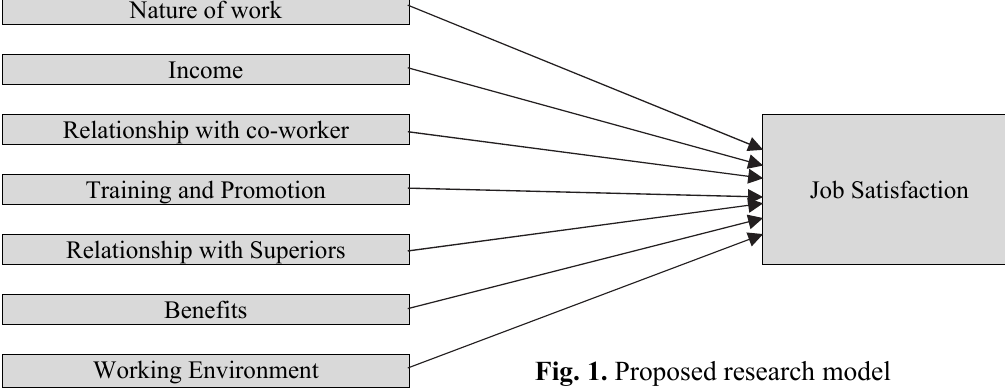
Fig. 1. Proposed research